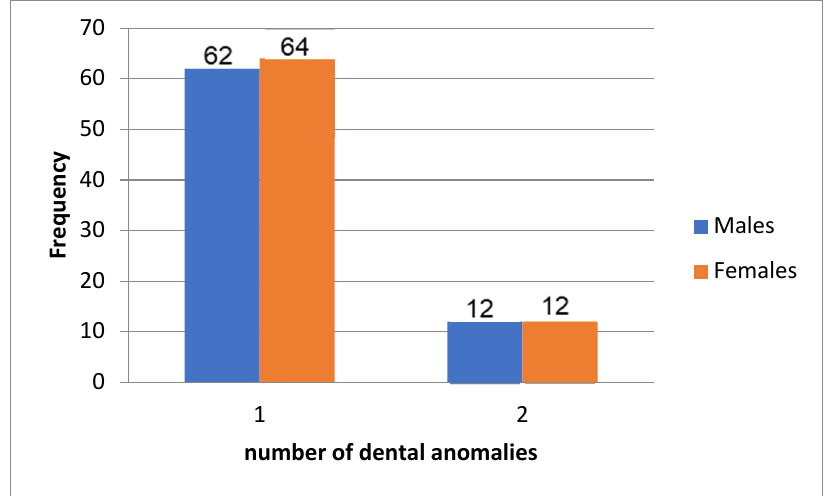
Figure 3. The number of dental anomalies in each case among males (blue) and females (red). The number of teeth involved in each case is shown in Figure 4. We found that the highest number was 12 teeth per case in both groups (males/females). This number was present only in two cases, one male and one female. The most common number of teeth involved in every case was found to be one tooth in males (32) 34.24% and two teeth in females (37) 48.68%.